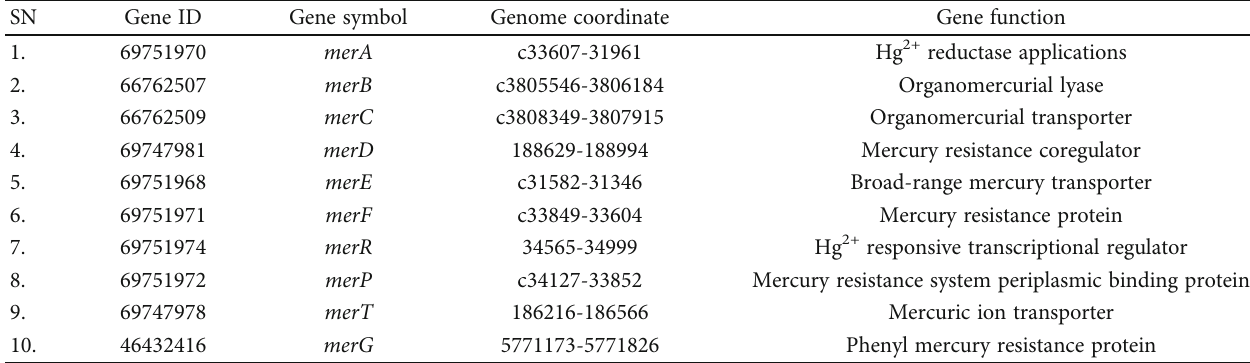
Table 1: Mercury bioremediation genes and their general function and genome